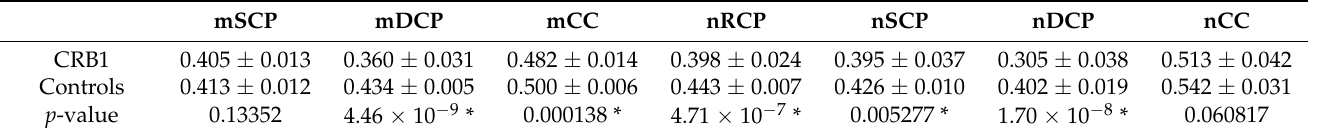
Table 2. Vessel density analysis at individual vascular plexa in CRB1 -associated retinal dystrophy and control